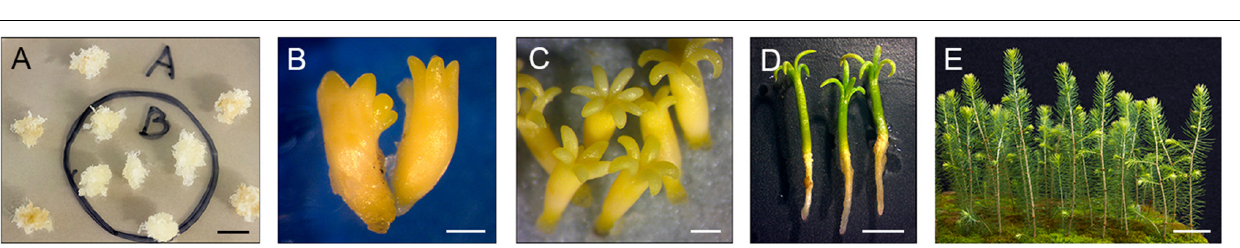
FIGURE 2 | Induction of EM sublines from PS explants. (A-C) 11Pa3794 genotype, (D–F) 11Pa4066 genotype. (A) Elongating primordial needles after 21 days of culture. (B) Proliferating EM after 8 weeks of culture. (C) Early somatic embryos stained with acetocarmine. (D,E) Proliferating EM after 6 weeks of culture. (F) Early somatic embryos stained with acetocarmine. Bars: (A,B,D,E) = 0.5 mm, ( C,F ) = 100 µ m.